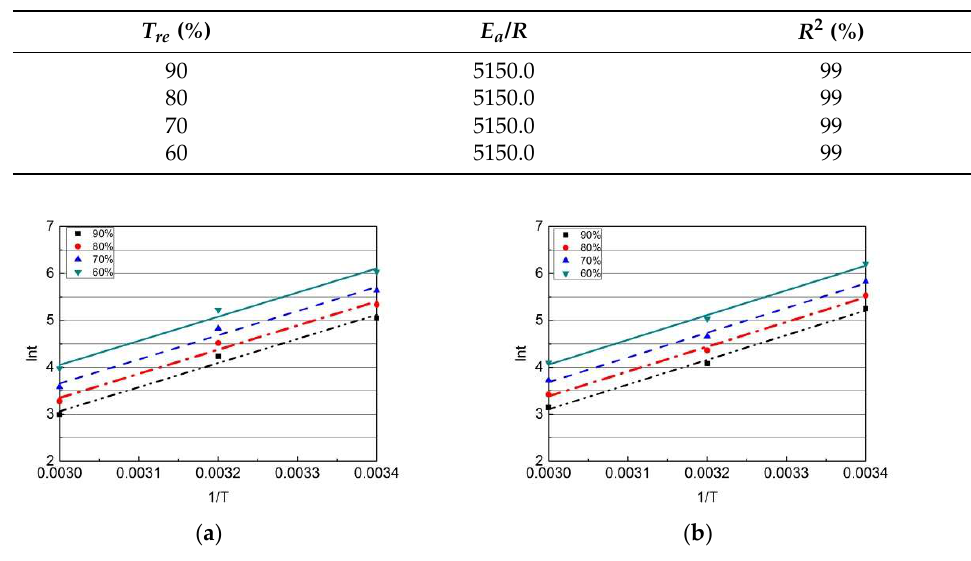
Figure 25. Arrhenius graphs based on the fourth prediction model: ( a ) G1; ( b ) G2. Table 16. Values of 𝐸 (cid:3028) 𝑅⁄ (G1) based on the fourth prediction model. 𝑻 (%) 𝒓𝒆